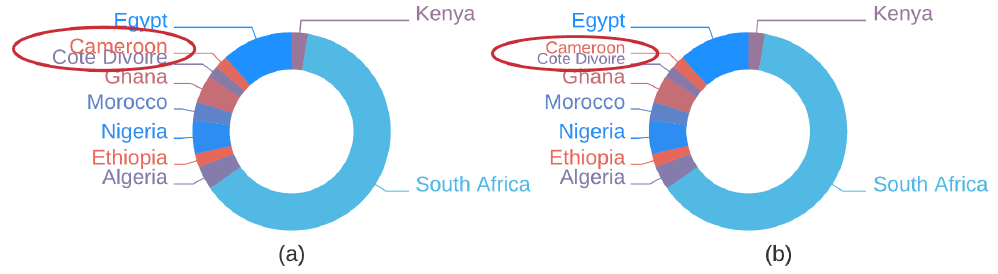
Figure 11. Example of removing overlap using local font size change : ( a ) before use; ( b ) after use. - Merge or split interactions: